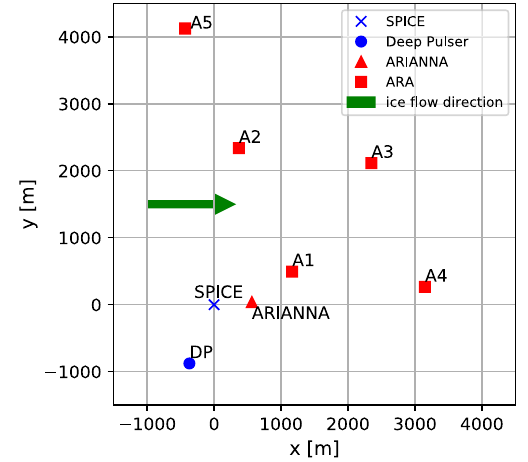
Fig. 5 The geometry of the measurement setup at the South Pole [22], with the SPICE hole for the transmitter in blue and the ARA and ARI- ANNA antenna stations in red. Also shown is the position of the deep pulser [21], another radio transmitter attached to the end of one of the IceCube strings